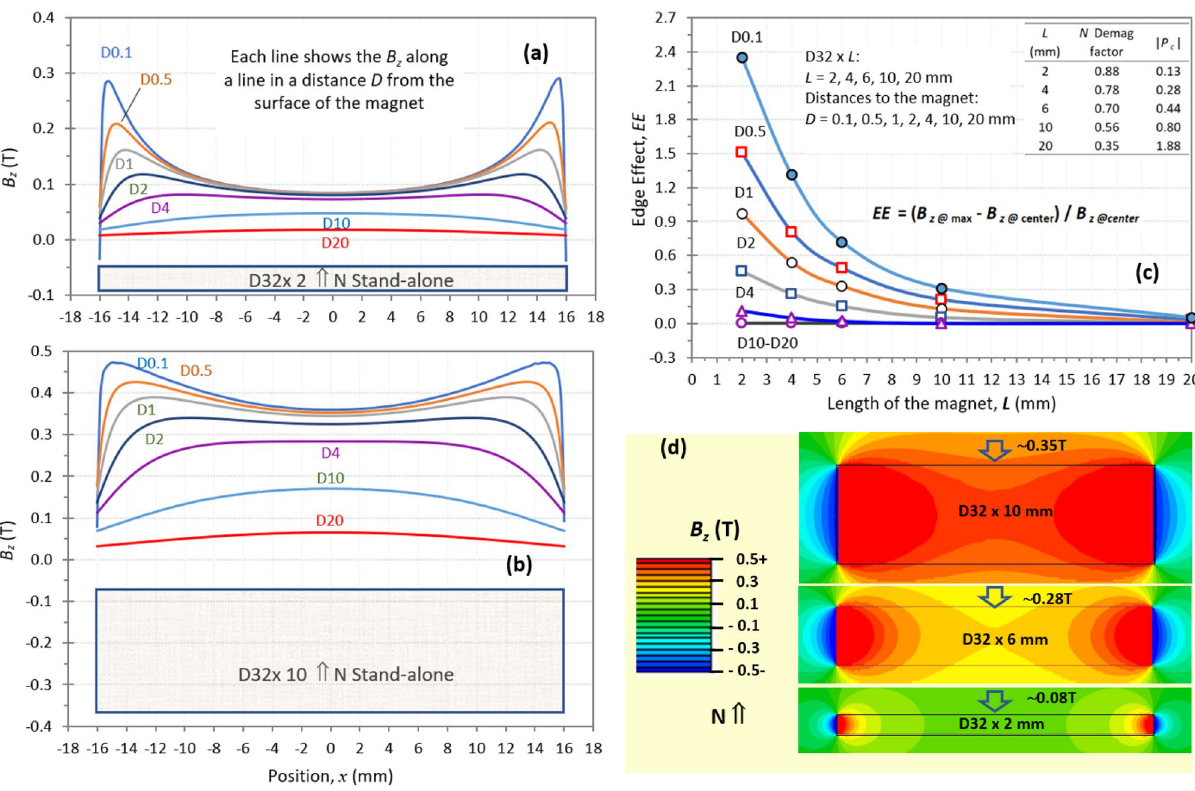
Figure 6. The FEA simulation shows the self-demagnetization and the EE vs. magnet length for a series of stand-alone N55 magnets with the same diameter and five lengths. The B z vs. x of D32 × 2 is shown in ( a ), and the B z vs. x of D32 × 10 is shown in ( b ). The EE values vs. magnet length and distance are shown in ( c ), and EE is defined as the difference between the maximum B z and the center B z over the center B z on the curve of B z vs. x : EE = ( B B B z@max − z@center ) / z@center . When the maximum B z is at the center, the EE becomes zero. The EE is 2.4 for the magnet of L = 2 mm, meaning the edge’s maximum B z is 240% higher than that of the center B z . The 2D B z maps at the cross-section through a diameter of the three magnets are shown in ( d ), in which the center B z of 0.35 T at L = 10 mm is over four times the center B z of 0.08 T at L = 2